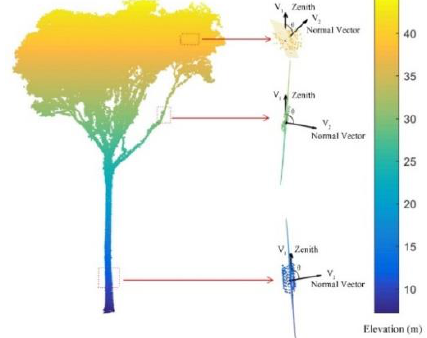
Figure 2. Zenith angles of different part of point clouds The zenith angle is the angle between the normal vector and